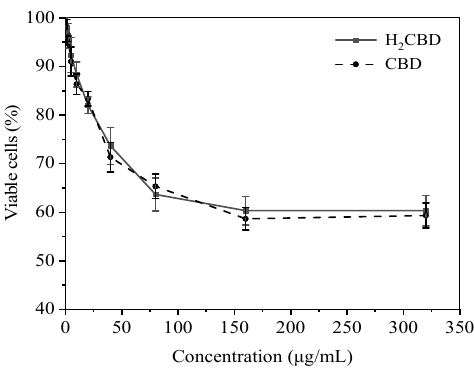
Figure 4. Toxicity of H 2 CBD or CBD towards human skin fibroblasts. Figure 4 indicates that the H 2 CBD showed a dose-dependent toxicity in the range of 1.25 µ g/mL to 80 µ g/mL, and the viable cells stabilized at around 60% at a H 2 CBD concentration of up to 320 µ g/mL. Both CBD and H 2 CBD presented lower toxicity to human skin fibroblasts at concentrations up to 64-fold higher than their MIC values (1.25 µ g/mL) against S. aureus